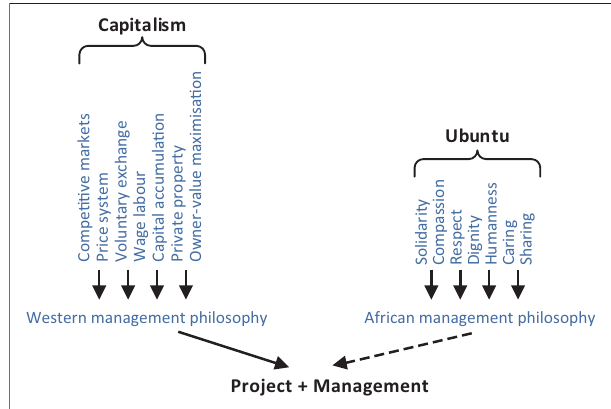
FIGURE 2: Infusing African management philosophy into project